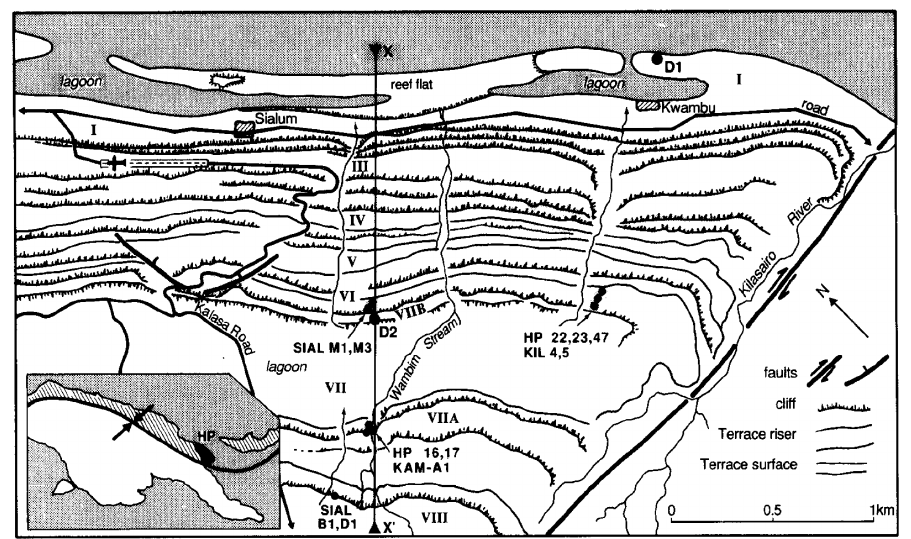
Figure 28. Location and generalized physiography of the emerged reef terraces on Huon Peninsula (from Stein et al., 1993). Spot elevations in metres. Reef numbering (I to VIII) follows Chappell (1974). Inset map shows position of study area in Papua New Guinea.